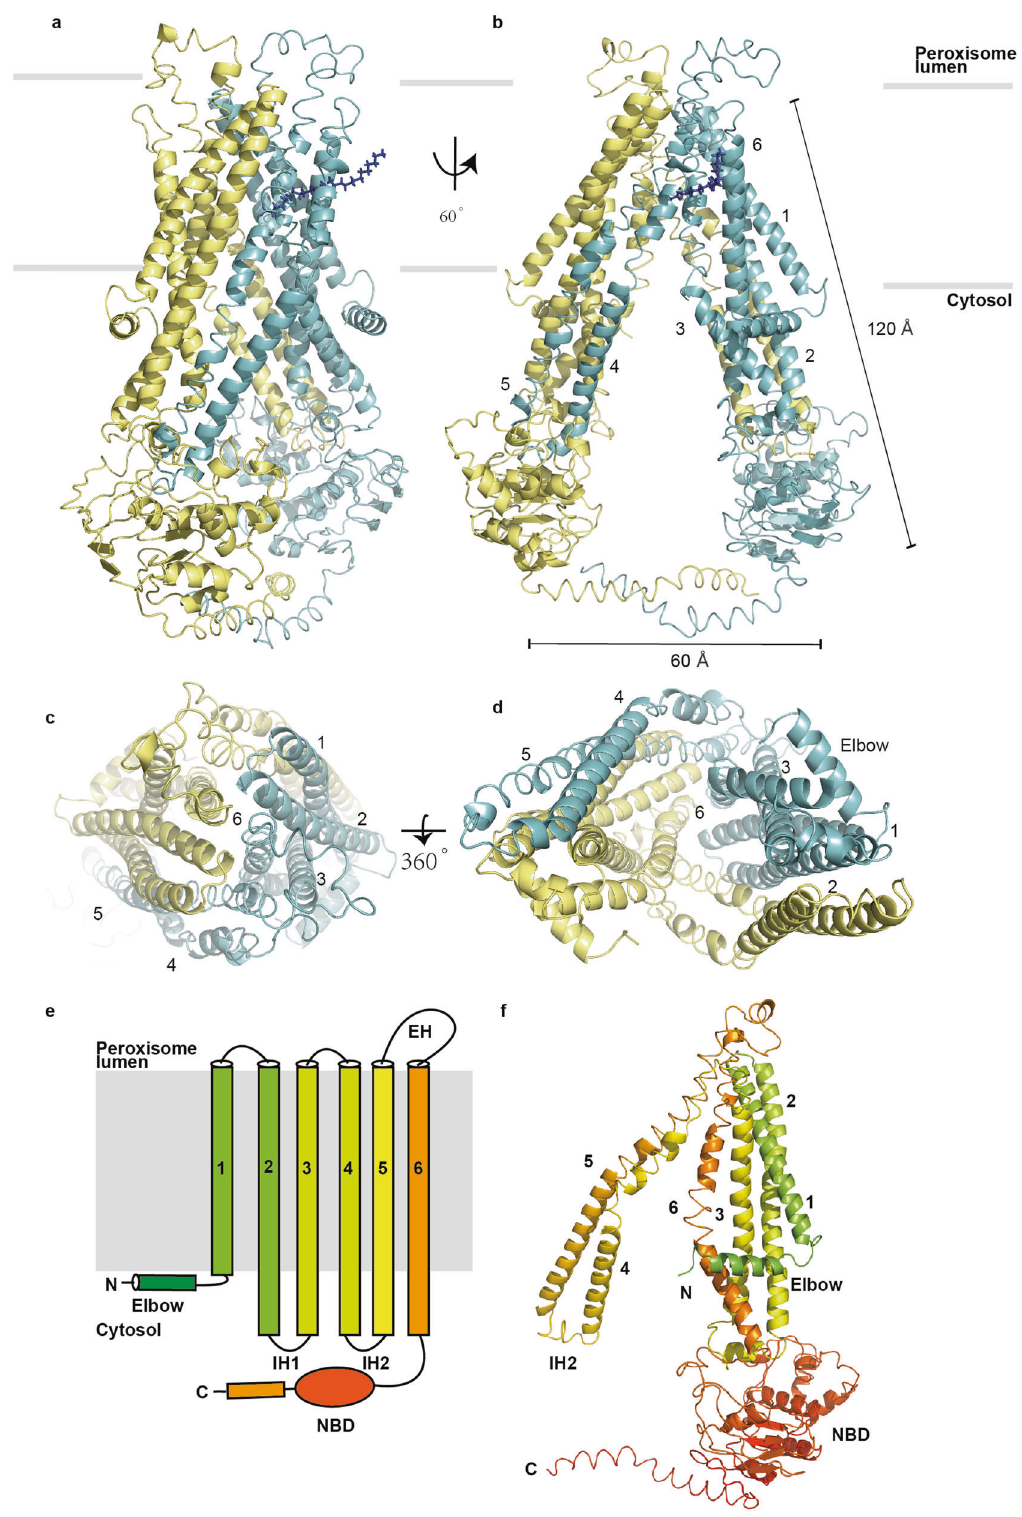
Fig. 2 Overall structure of ABCD1 in complex with C26:0 fatty acid. a , b Cartoon representation of the side view of the overall structure of ABCD1. The two subunits are colored in cyan and yellow. c , d TMD of ABCD1 viewed from peroxisomal lumen and cytosol. e , f Domain structures of ABCD1